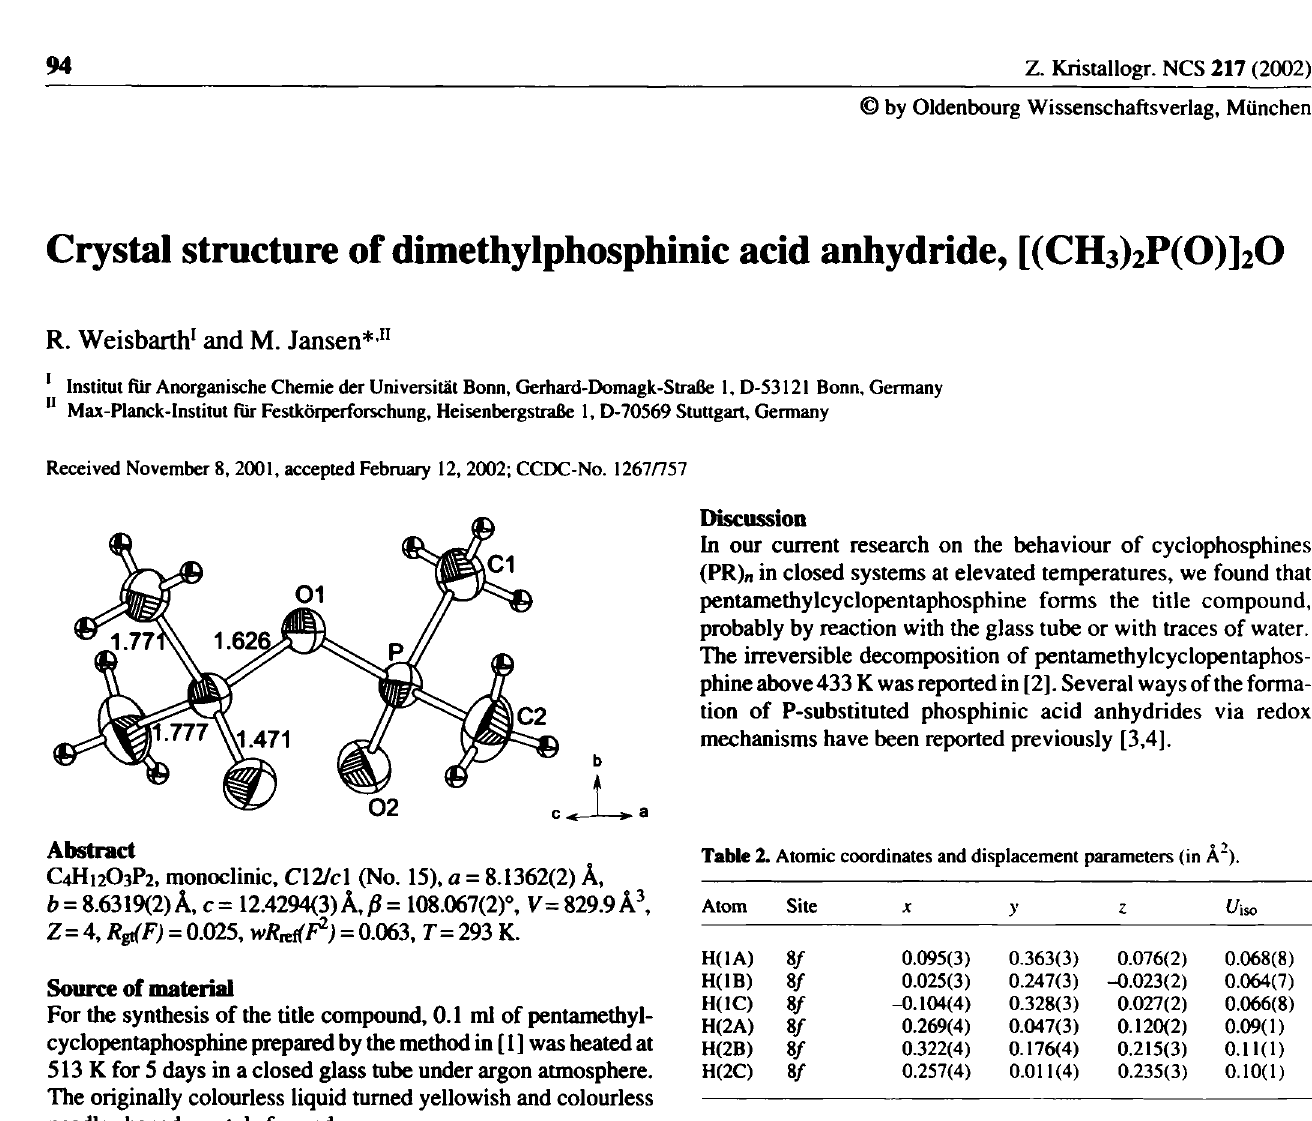
Table 1. Data collection and handling.